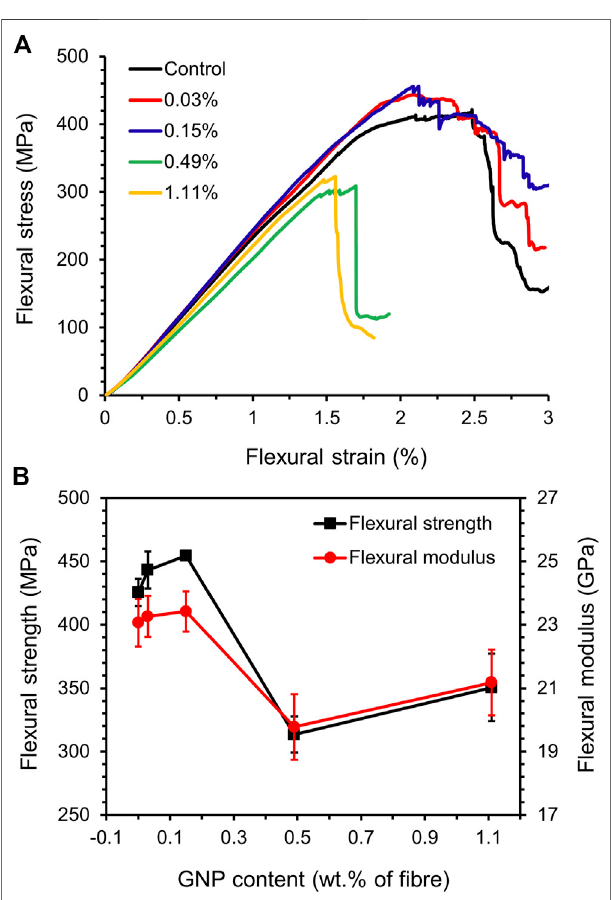
FIGURE 8 | (A) Stress – strain curves of GFRP composites with different GNP loadings under four-point bending. (B) Flexural strength and modulus of the